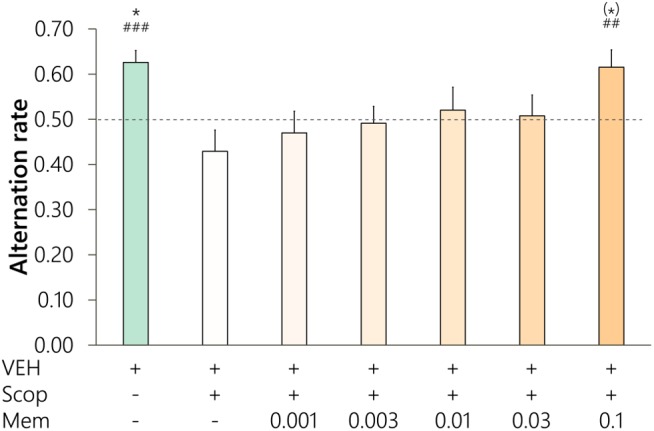
Dose-response relationship for memantine against scopolamine-induced (0.5 mg/kg, i.p.) amnesia in the spontaneous alternation task (n = 9, Long Evans rats). Text below the graph represents the injections given before testing a given treatment, also showing the dose of memantine (mg/kg, s.c.). Significance level of post hoc comparisons between a given treatment and scopolamine alone treatment were marked with asterisks above the bars: (∗) p < 0.1, ∗p < 0.05. Hash symbols mark that the alternation performance after the given treatment was significantly higher than the chance level (0.5, dashed line): ##p < 0.01, ###p < 0.001.